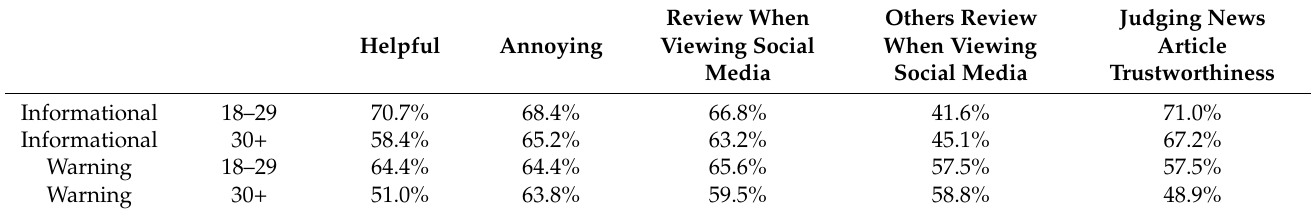
Table 13. Informational/warning labeling survey results by category and by age group.